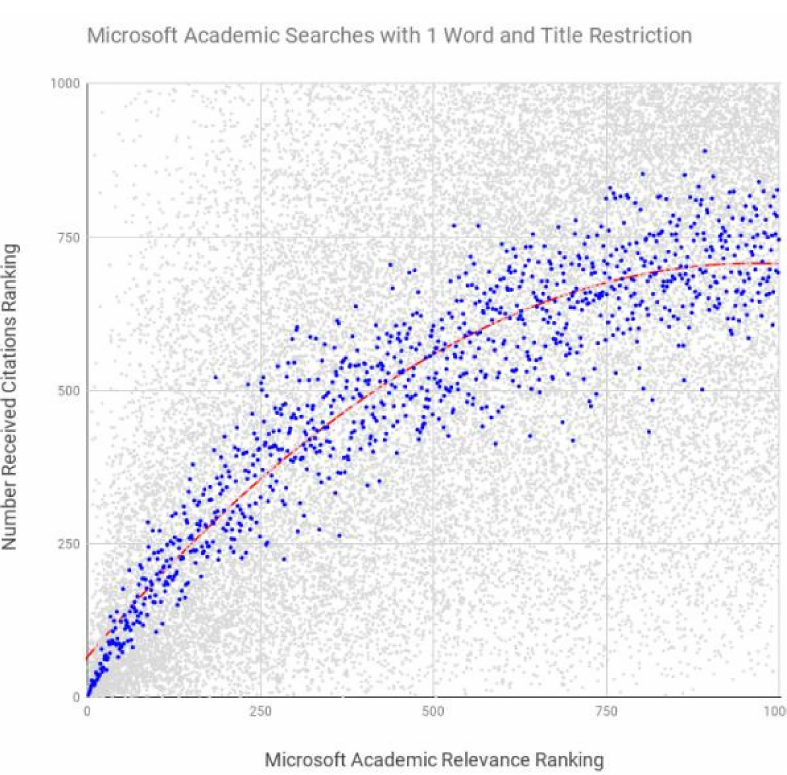
Figure 5. Microsoft Academic Searches with One Word and Title Restriction (rho 0.907, median in blue, the rest of data in gray).